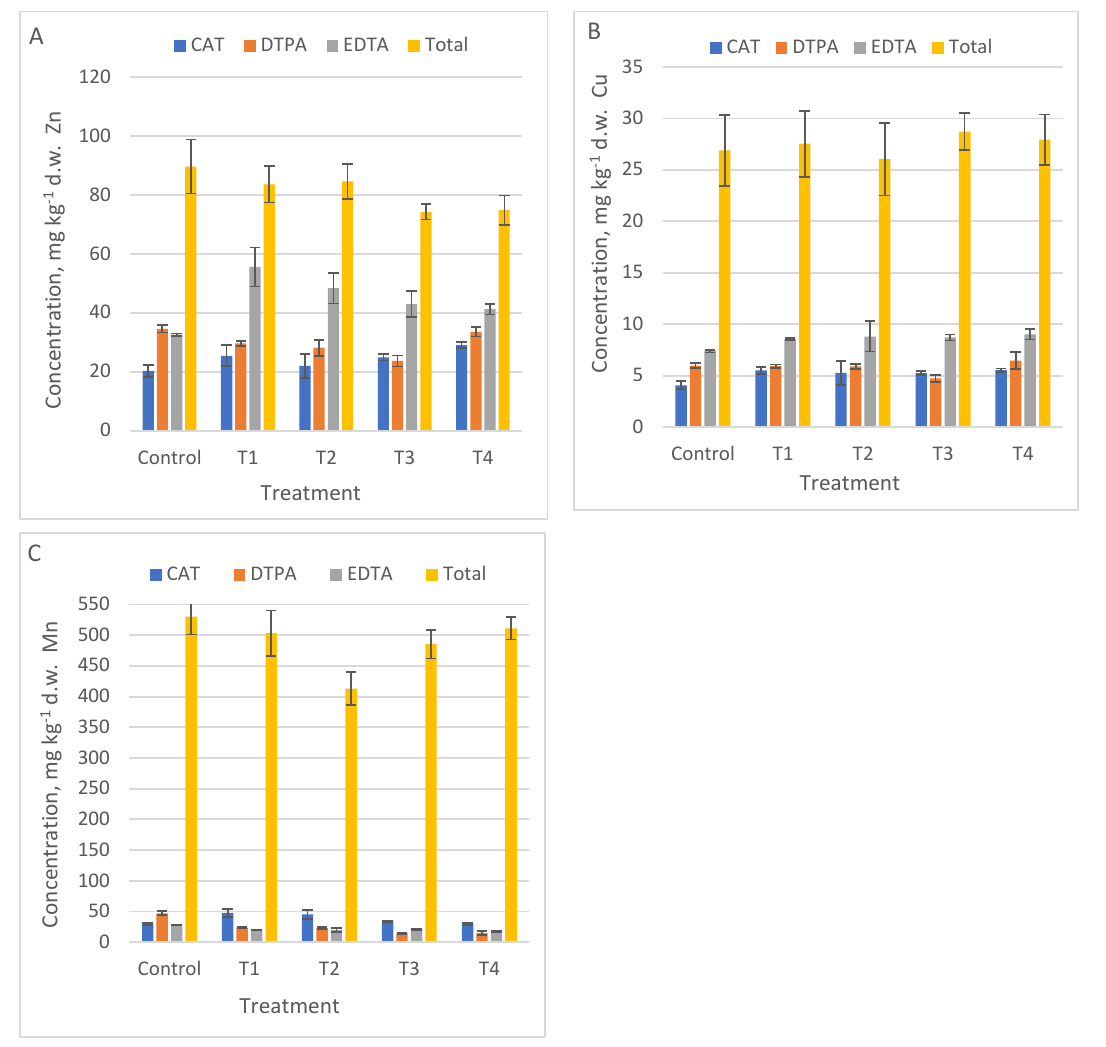
Figure 2. The mobile metallic concentration of micronutrients in Control, and T1 to T4 treatments using three single chemical extraction procedures: DTPA, CAT, EDTA compared to total content, (average ± SD, n = 3): ( A ) Zn, ( B ) Cu, ( C ) Mn. Table 5. Statistical analysis of extraction methods used for mobile metals ( p -values).